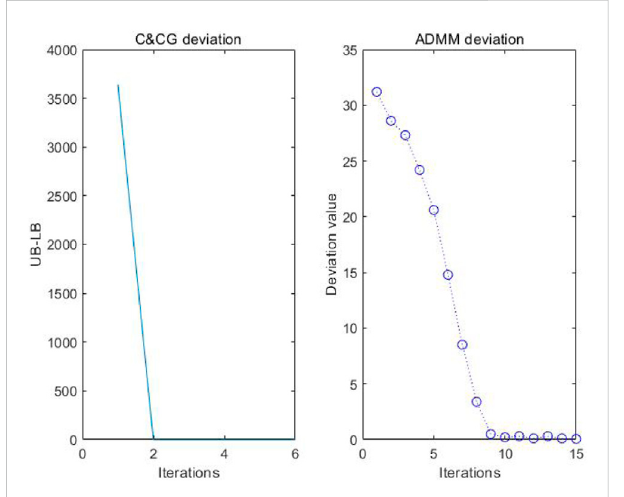
FIGURE 5 Convergence curves of the ADMM and CCG algorithms.